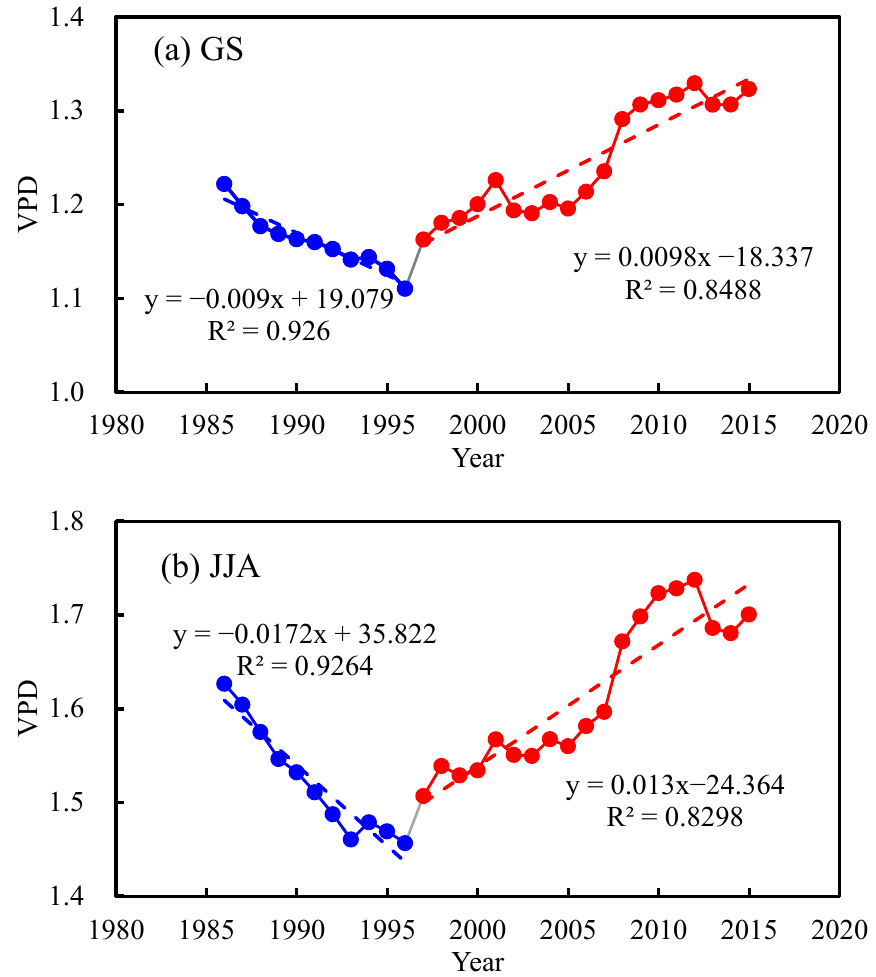
Figure 8. 5-year moving average of VPD over the GS ( a ) and JJA ( b ). Blue and red lines represent the linear fit before and after the TP years.